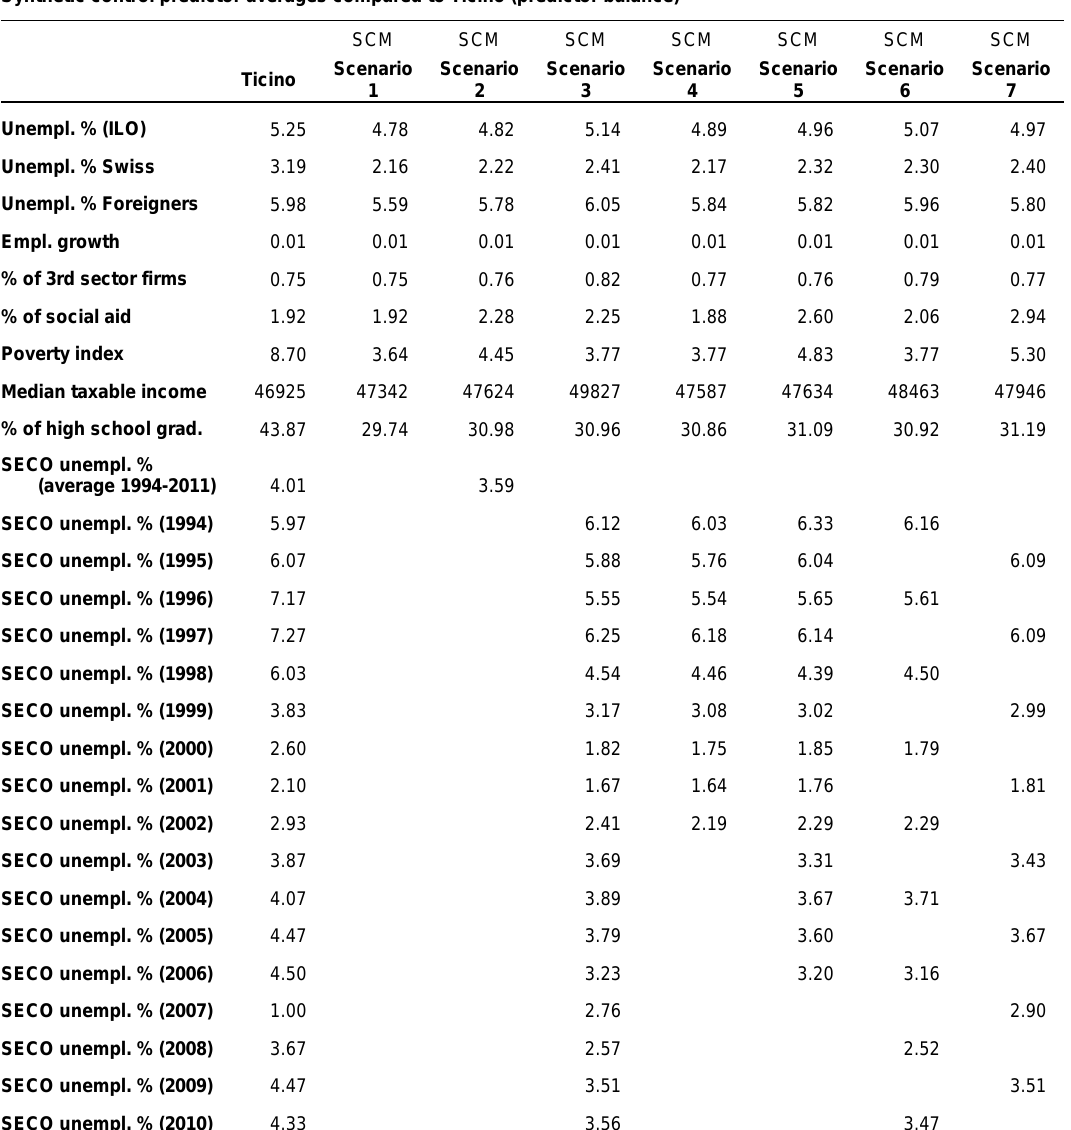
Table 4. Predictor weights in defining the SC from the cantons in the donor pool. Synthetic control predictor averages compared to Ticino (predictor balance)